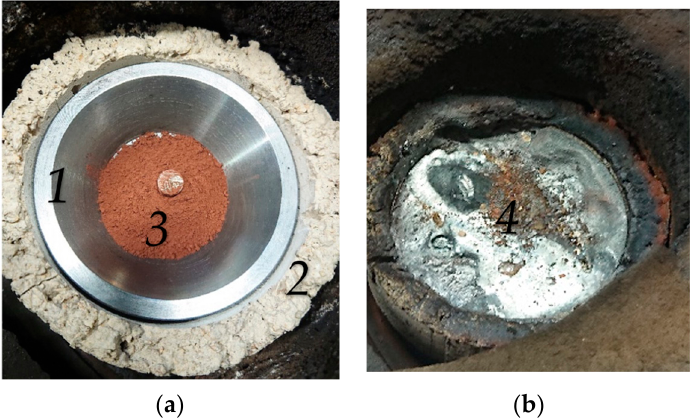
Figure 8. Crucible before ( a ) and after ( b ) Trial B50/C1.04.